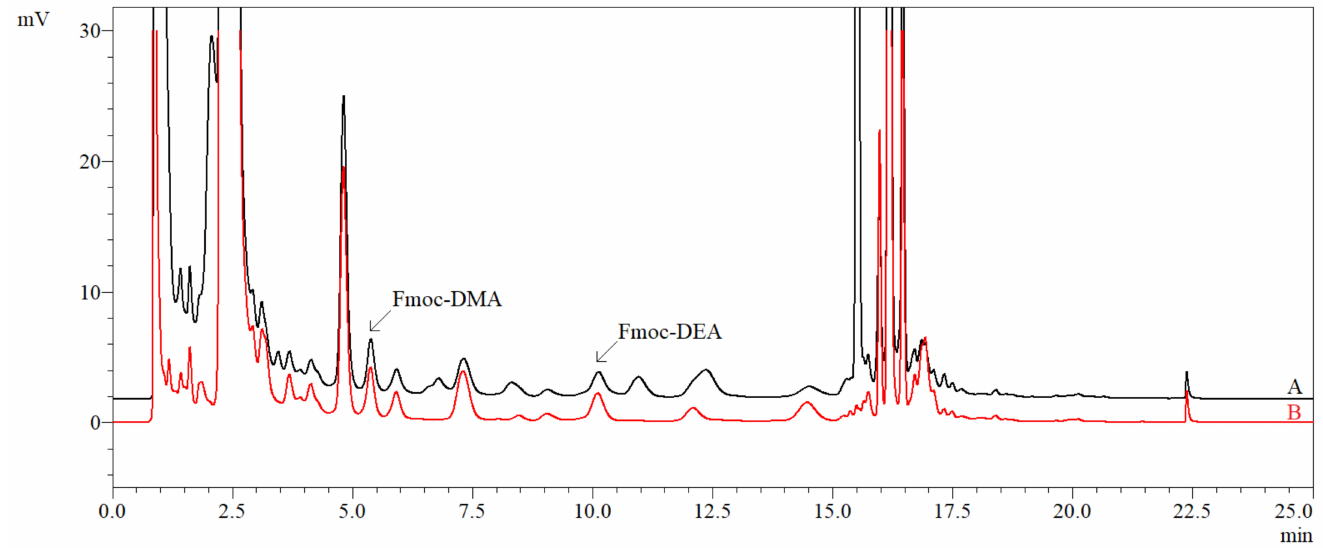
Figure 6. Chromatograms of the enalapril maleate sample ( A ) and the blank solution ( B